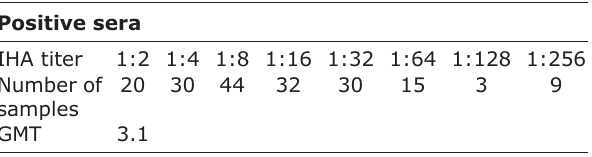
Table-2: IHA titer for infectious bursal disease in local chickens and guinea fowls. Positive sera IHA titer